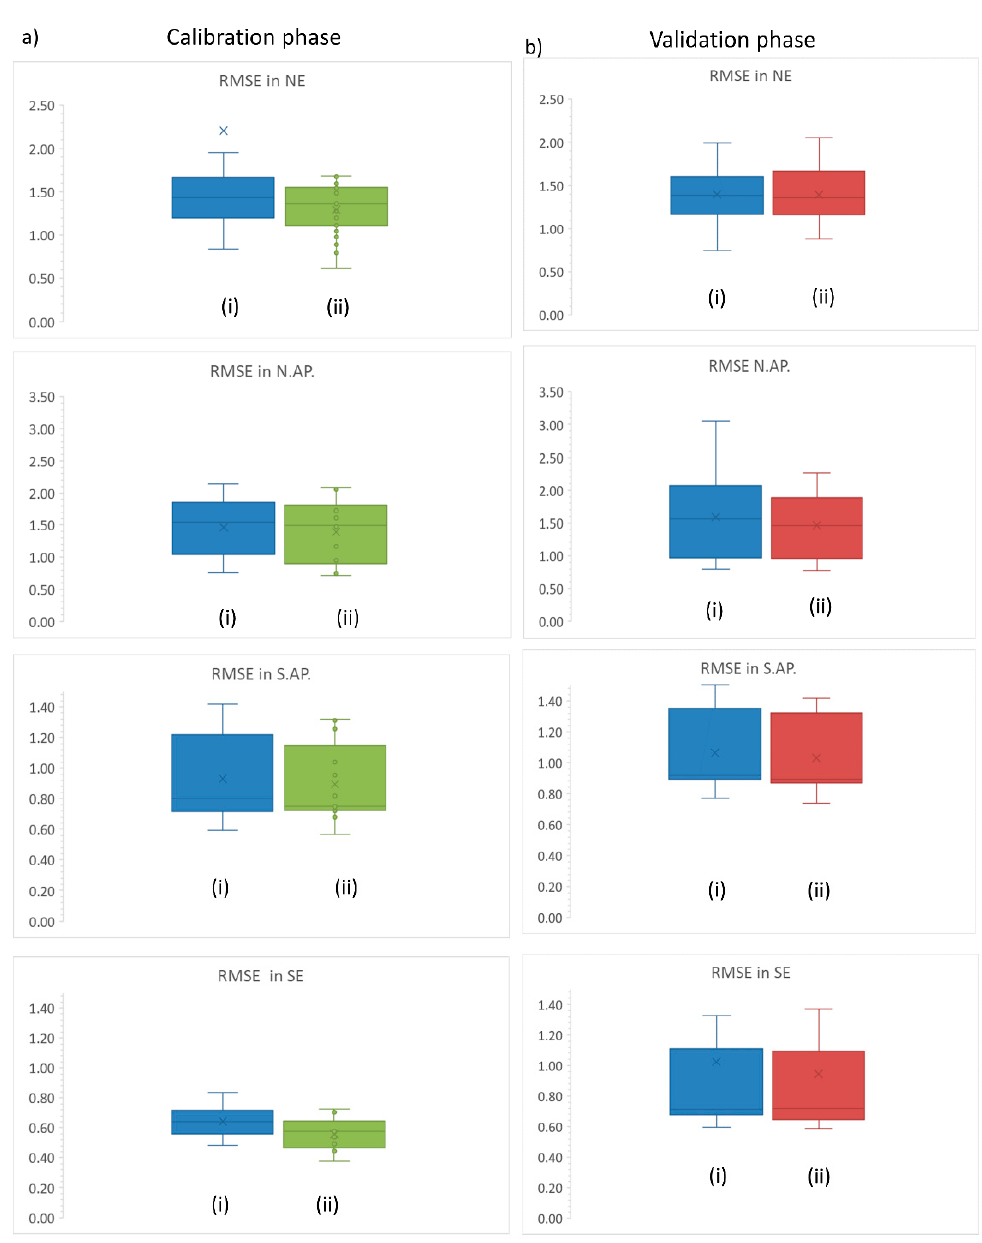
Figure 5. RMSE results calculated from predicted and simulated discharges using a priori and calibrated parameters in calibration (panel ( a ) of the Figure) and validation (panel ( b ) of the Figure). In panels ( a , b ), the boxplots ( i ) used the a priori parameters and the boxplot ( ii ) used the calibrated parameters. NE stands for north east, N.AP. stands for North Appalachian, S.AP. stands for south Appalachian, SE stands for south east.